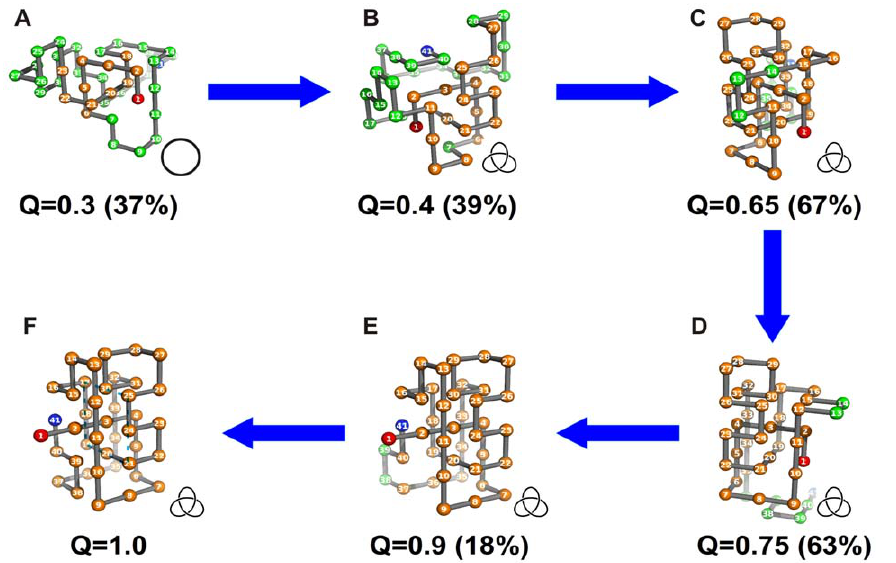
Figure 8. Knotting mechanism operating in the bulk. Each conformation with fraction of native contacts Q is the closest to the cluster’s centroid, and is taken as the cluster’s representative. The residues colored in orange have at least two of its native contacts formed. In parenthesis we show the ratio between the size of the cluster (i.e. its number of conformations) and the size of the initial ensemble of conformations with fraction of native contacts Q . In (D) we highlight the loop formed by residues 17–21, 24,25,30.